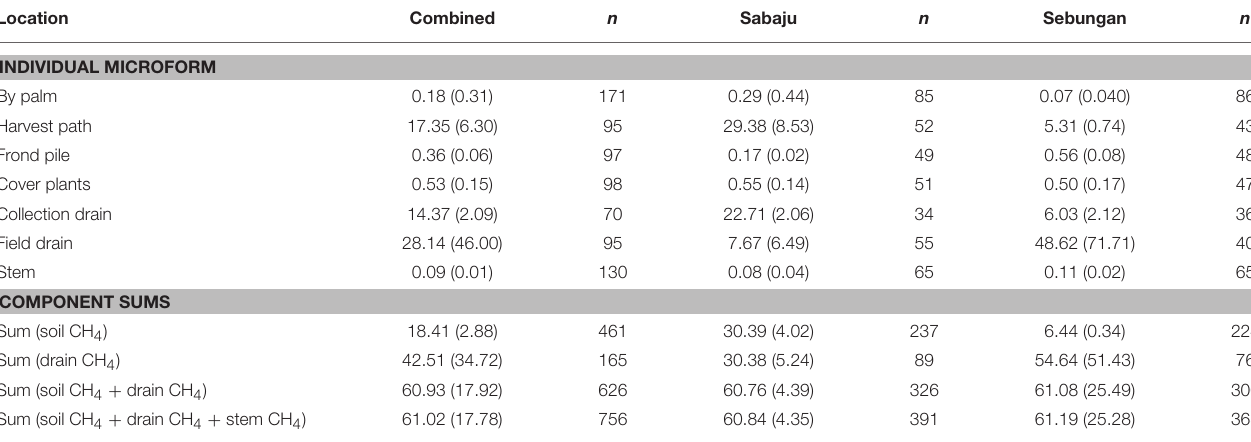
TABLE 4 | Annual upscaled CH 4 fluxes from the different surface microforms sampled at both plantations and at Sabaju and Sebungan individually. Location INDIVIDUAL